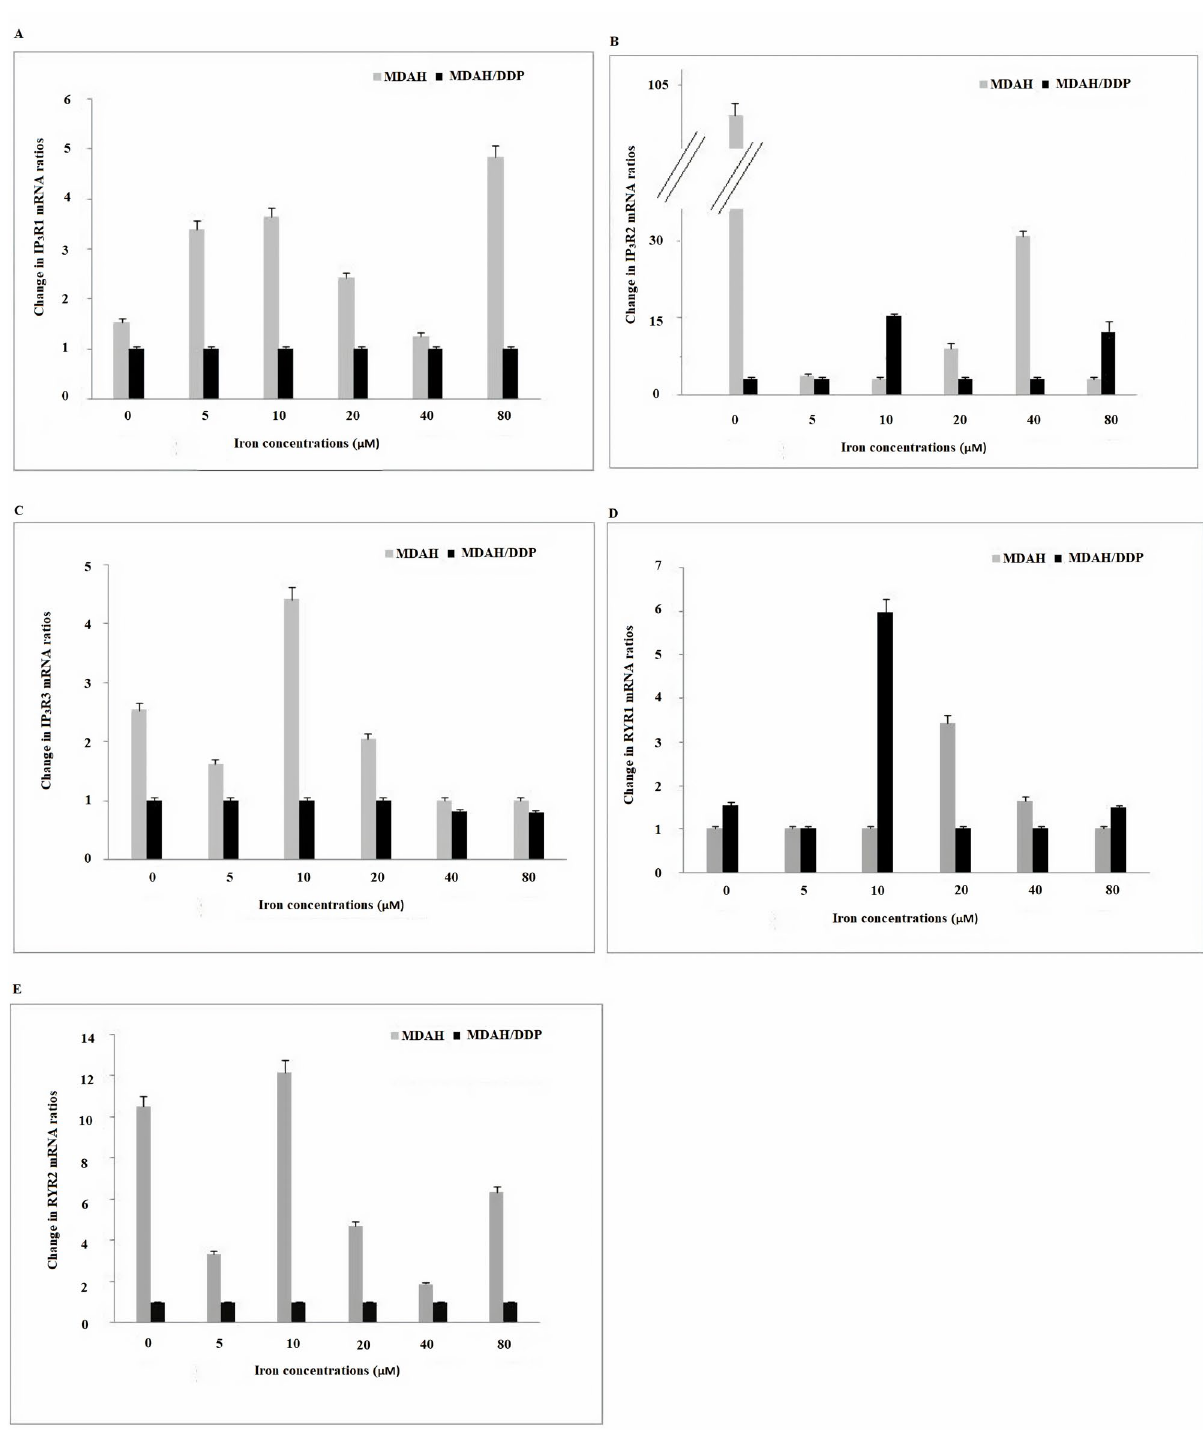
Figure 2. Gene expression of the IP3R1/2/3 , RYR1 and RYR2 Ca 2+ channels in the ER in MDAH and MDAH/DDP cells treated with increasing iron concentrations. The levels of change in mRNA gene expression rates for each sample were determined with respect to actin by RT-PCR method. A: IP3R1 ; B: IP3R2 ; C: IP3R3 ; D: RYR1 ; E: